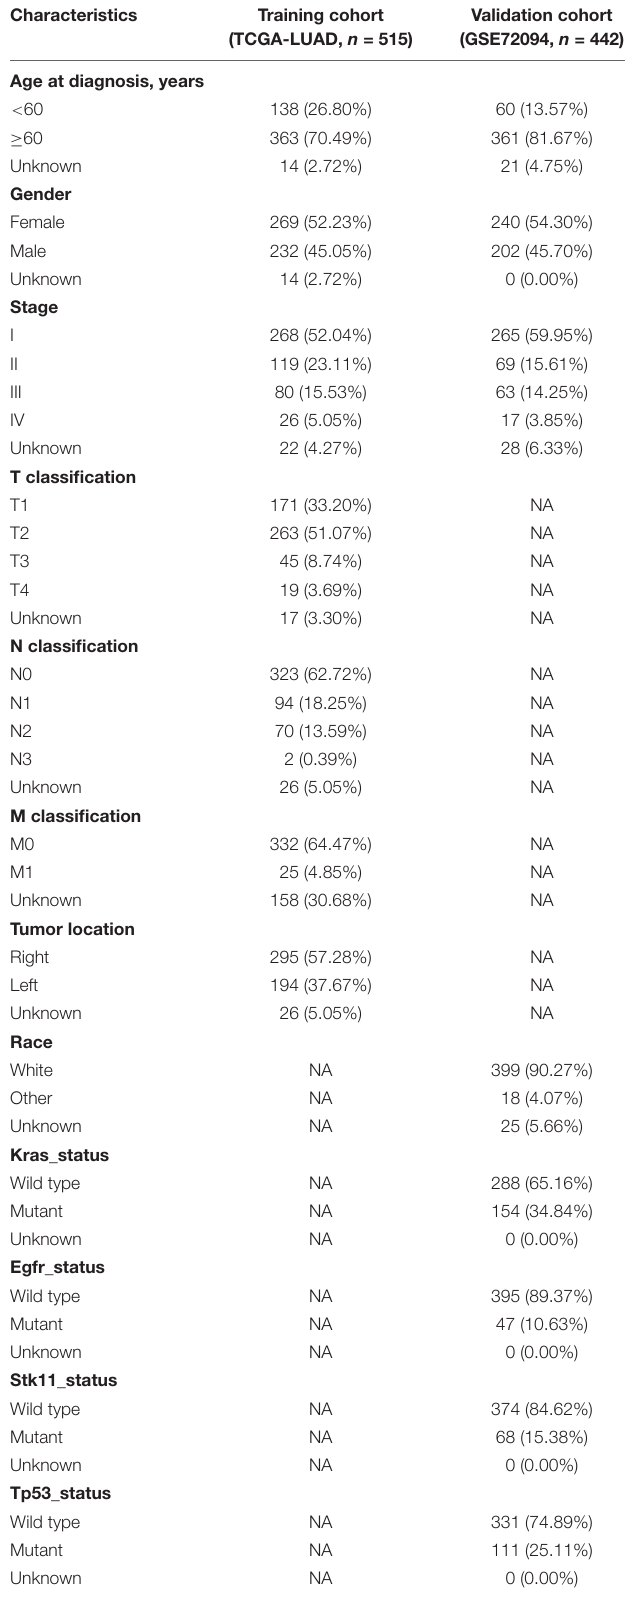
TABLE 1 | Clinical characteristics of patients involved in the study.